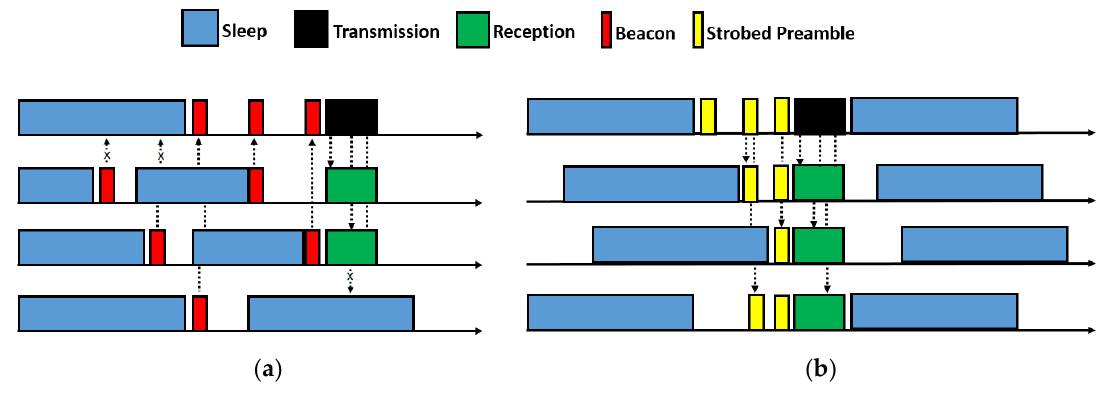
Figure 18. ( a ) LPP duty cycling, ( b ) Strobed LPL duty cycling.